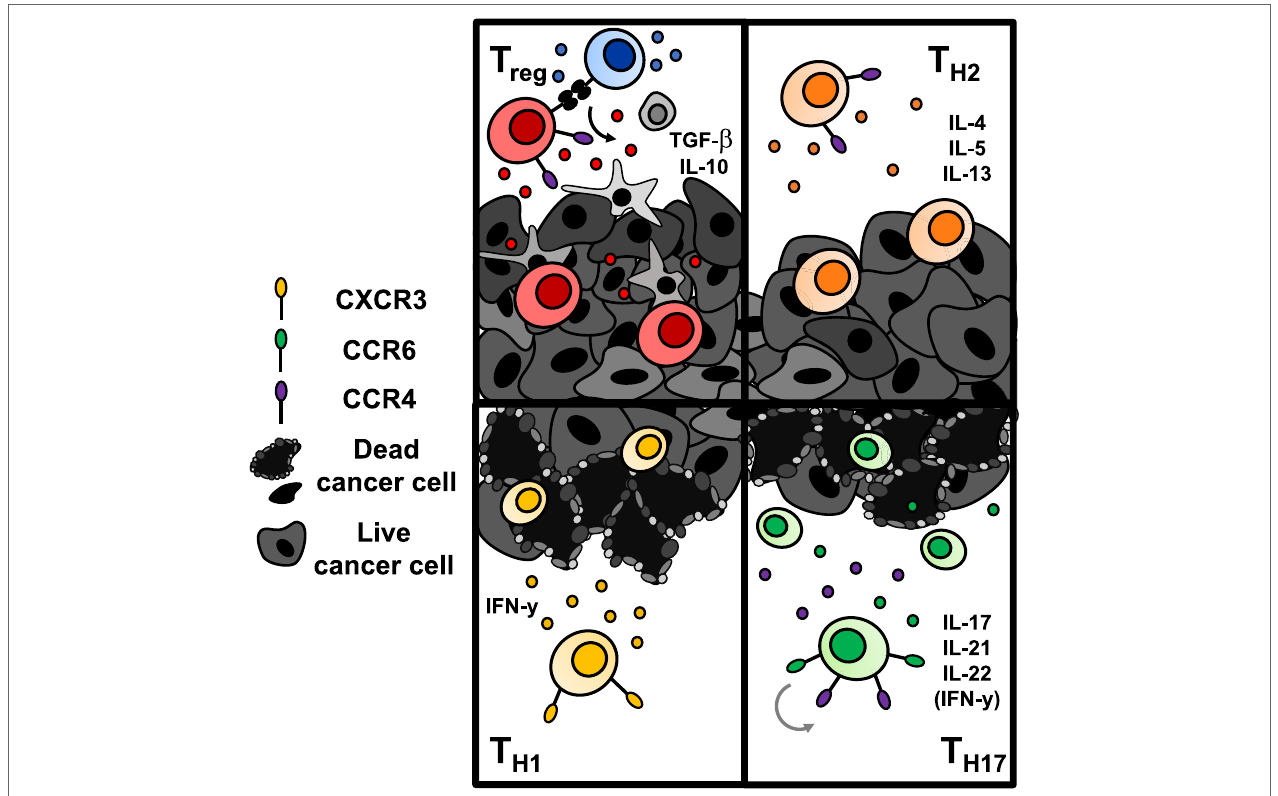
FigURe 5 | Antitumor immunity of CD4 + T cells is dependent upon the subset to which they are polarized. Regulatory T cells (Tregs) (top left) and Th2 cells (top right) are classically tumor promoting. Tregs downregulate effector T cell responses via secretion of suppressive cytokines or engagement of inhibitory checkpoint molecules like CTLA-4 or TIGIT. Th2 cells secrete suppressive cytokines that hinder a Th1-mediated antitumor response. Conversely, transfer of Th1 cells (bottom left) and Th17 cells (bottom right) enhance antitumor responses. Th1 cells produce IFN- γ and enhance CD8 + cell-mediated immunity. Th17 cells produce proinflammatory cytokines that have controversially been implicated in carcinogenesis; however, adoptive transfer of Th17 cells has shown robust immunity in several solid tumors. Transferred Th17 cells have stem-like self-renewal capabilities and enhanced persistence long term over Th1